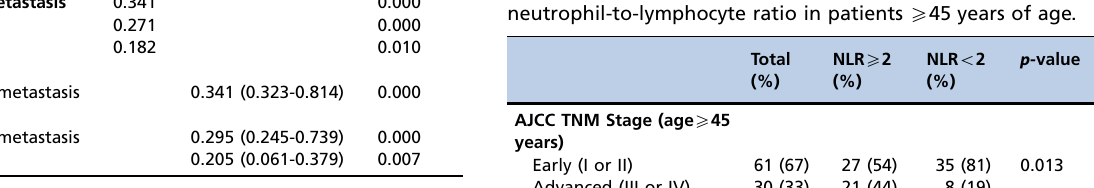
Table 4 - American Joint Cancer Committee TNM stage